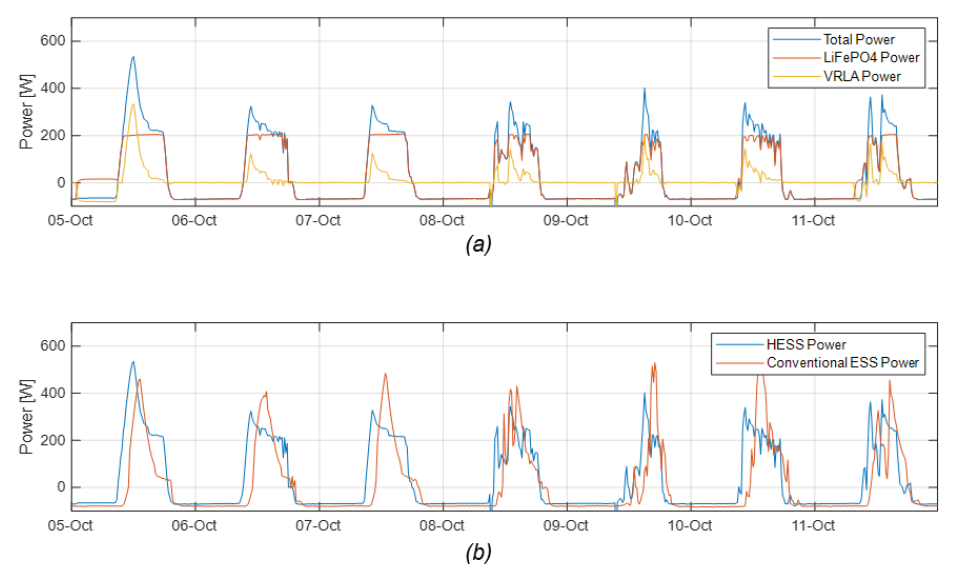
Figure 16. Power flows within the HESS ( a ), Power flows in the HESS and in the Conventional ESS ( b ); October 2018.